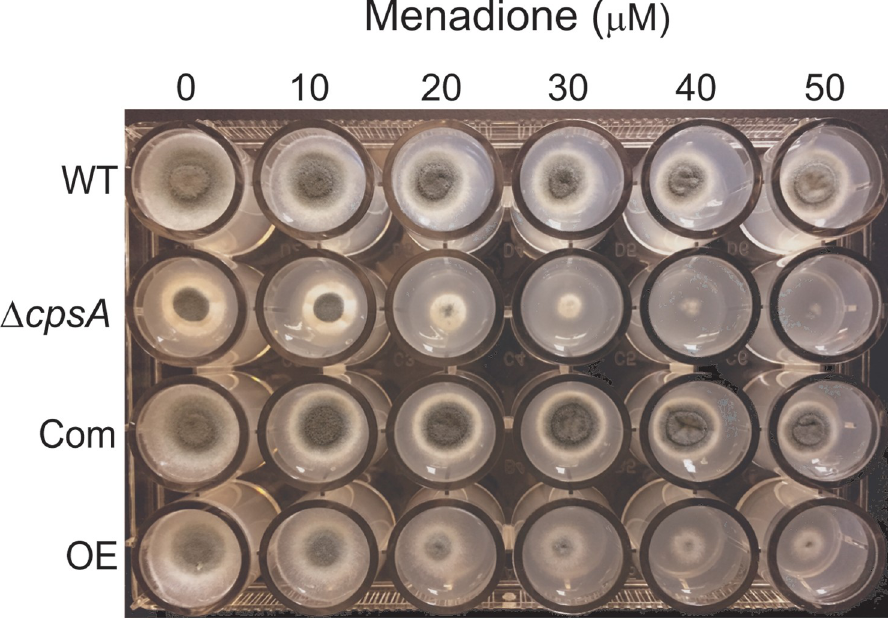
Fig 5. cpsA is required for normal resistance to oxidative stress. A 24-well plate containing GMM supplemented with different concentrations of menadione, was point-inoculated with the A . fumigatus wild type, Δ cpsA , Com and OE strains and incubated at 37 ˚C for 72